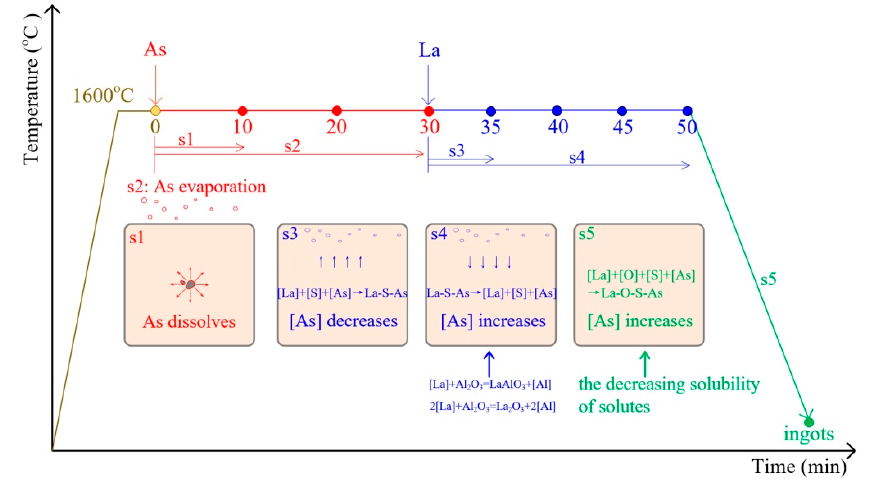
Figure 9. The existing state of arsenic in the steelmaking process and its distribution in the ingot.